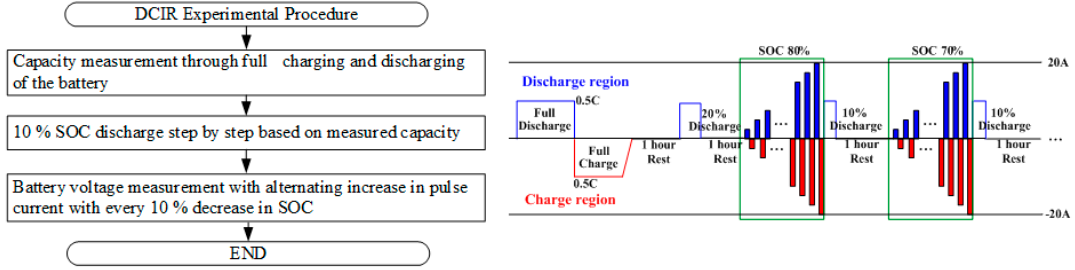
Figure 7. Experimental procedure for direct current internal resistance (DCIR) profile.